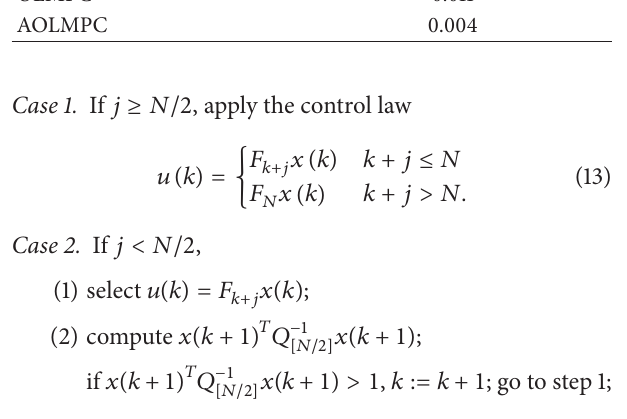
Algorithm 9 (modified automatic offline robust MPC). Con-